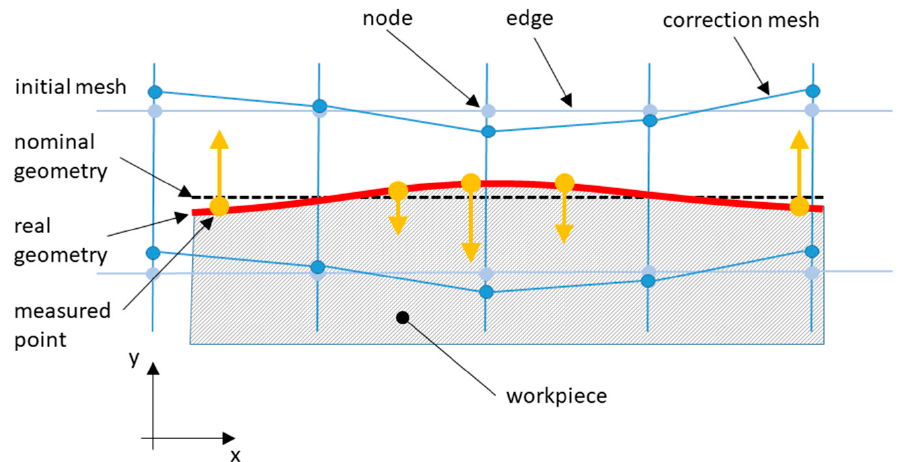
Figure 2. Scheme of a 1-dimensional task for correction mesh calculation.